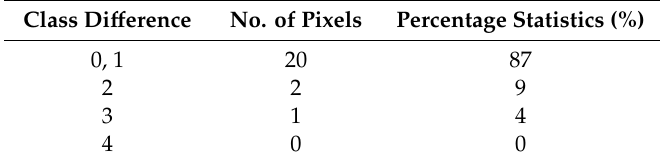
Table 6. Pixel pair comparison of groundwater vulnerability model in the Piedmont region